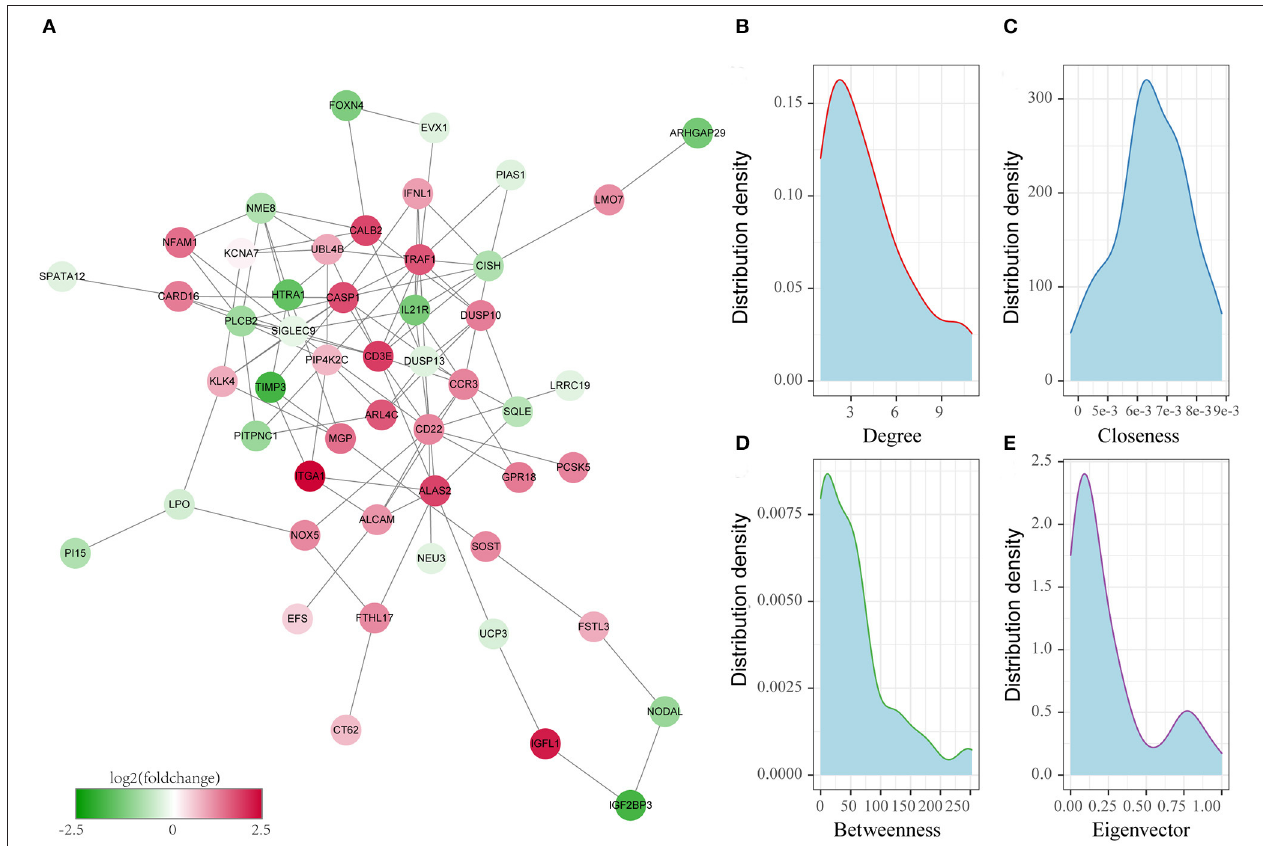
FIGURE 4 | Identification of the key oxaliplatin resistance-related genes for predicting the prognosis of colon cancer. (A) Protein–protein interaction (PPI) network of prognostic genes related to oxaliplatin resistance. (B) Degree distribution of genes in the network. (C) Closeness centrality distribution of genes in the network. (D) Betweenness centrality distribution of genes in the network. (E) Eigenvector centrality distribution of genes in the